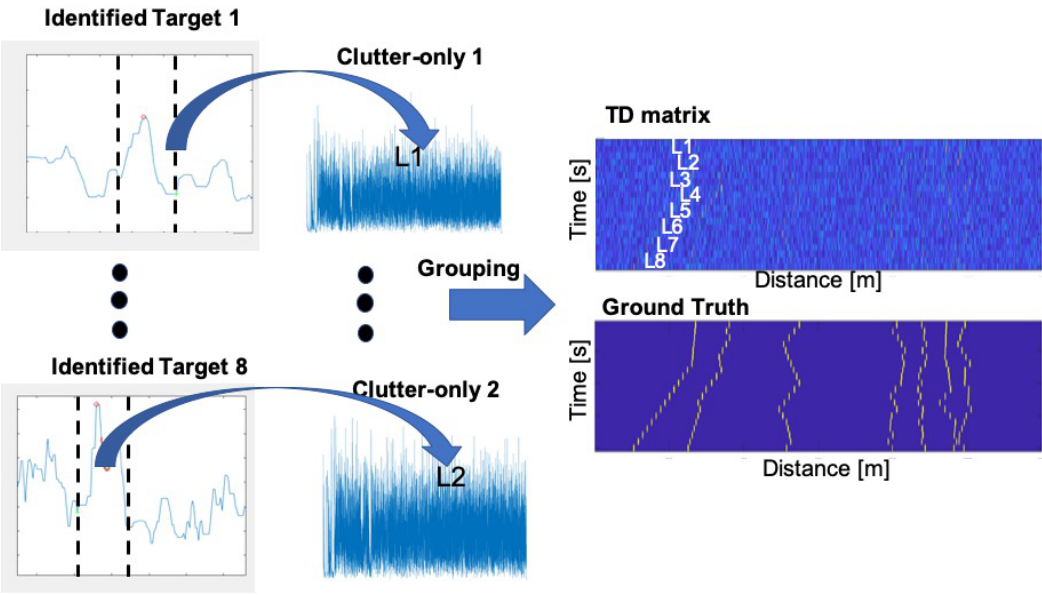
Figure 3. Illustration of the process of data augmentation to create time-distance (TD) matrices. Targets identified by the process described in Reference